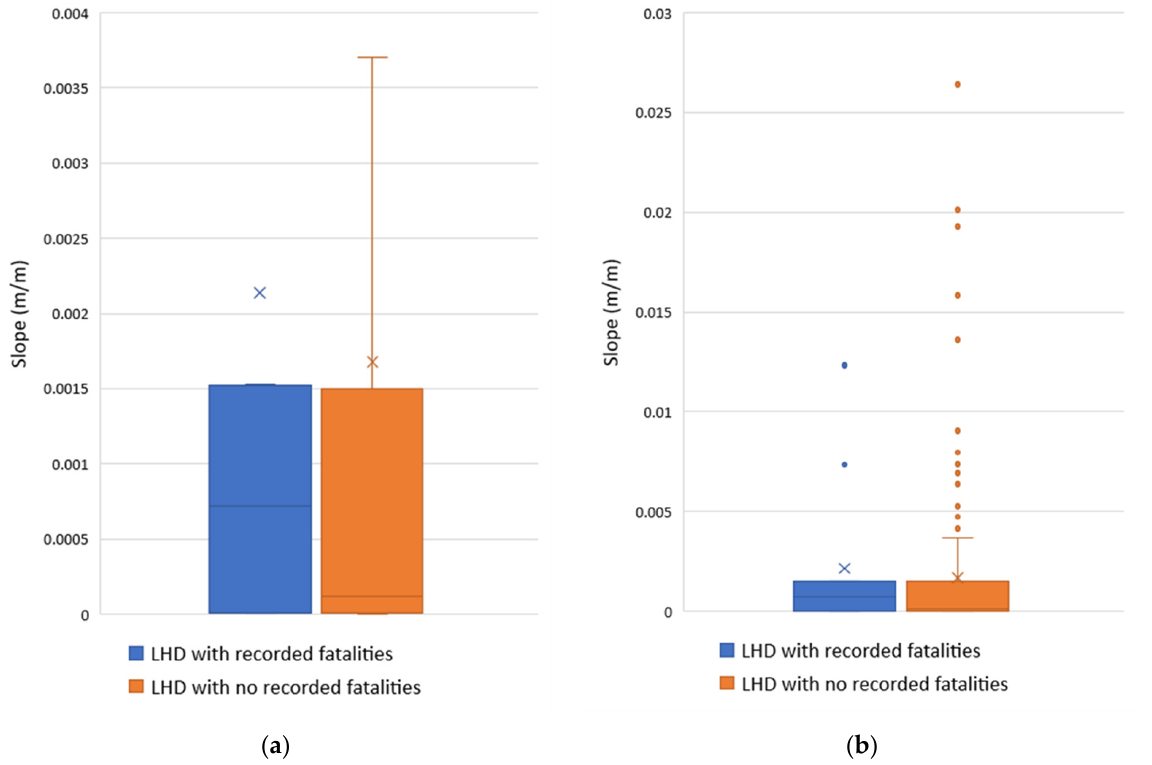
Figure A6. Stream slope at low head dams (LHDs) in Indiana: ( a ) box and whisker plot cutting off the outlier points for low head dams with no recorded fatalities ( b ) The same plot showing the whole range of outlier points for both distributions.